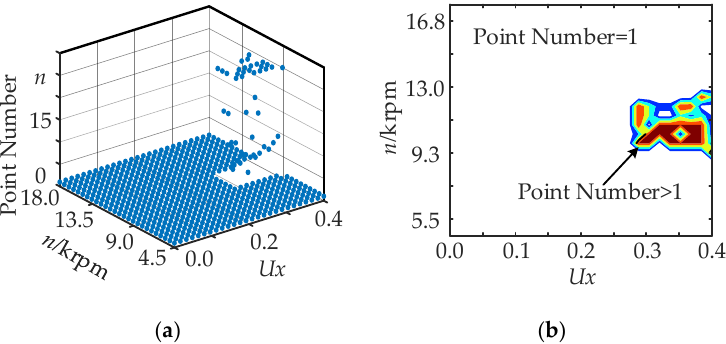
Figure 15. Poincare mapping with different eccentricity ratio and rotation speed. ( a ) U x - n -point diagram; ( b ) U x - n diagram.